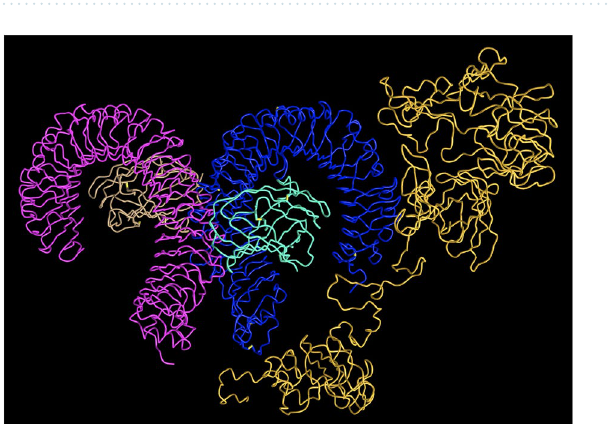
Figure 11. Final Vaccine in silico cloning into the pET28a( +) vector. The codon sequence of the final vaccine is in red, which is a 2082 bp gene sequence generated by the JCat server. The pET28a( +) expression vector is in black. The codon sequence is inserted between Eco53KI (188) and EcoRV (1573), forming a clone with a toal length of 6066 bp. This image was created by SnapGene 5.1.5 software (from Insightful Science; available at https ://www.snapg ene.com).